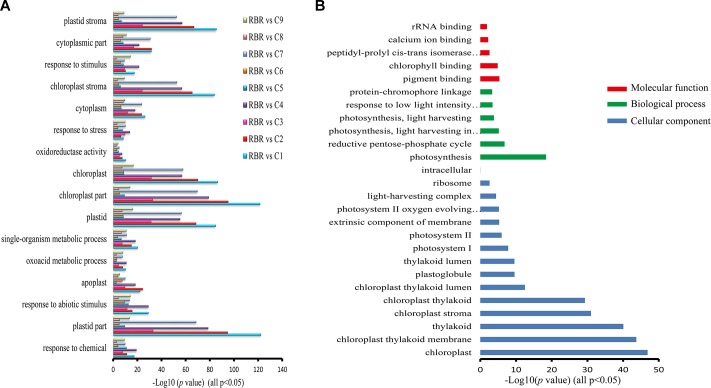
GO enrichments for co-regulated DEGs in all pairwise comparisons and DEGs identified in more than four comparisons. (A) A total of 17 GO terms that are particularly involved in biotic and abiotic stresses are enriched with DEGs in all pairwise comparisons (FDR, p < 0.05). The x axis represents the value of –log10(p-value). (B) GO analysis of DEGs that are identified in more than four pairwise comparisons exhibiting these DEGs are predominantly associated with photosynthetic process and protein synthesis. The x axis represents the value of –log10(p-value).